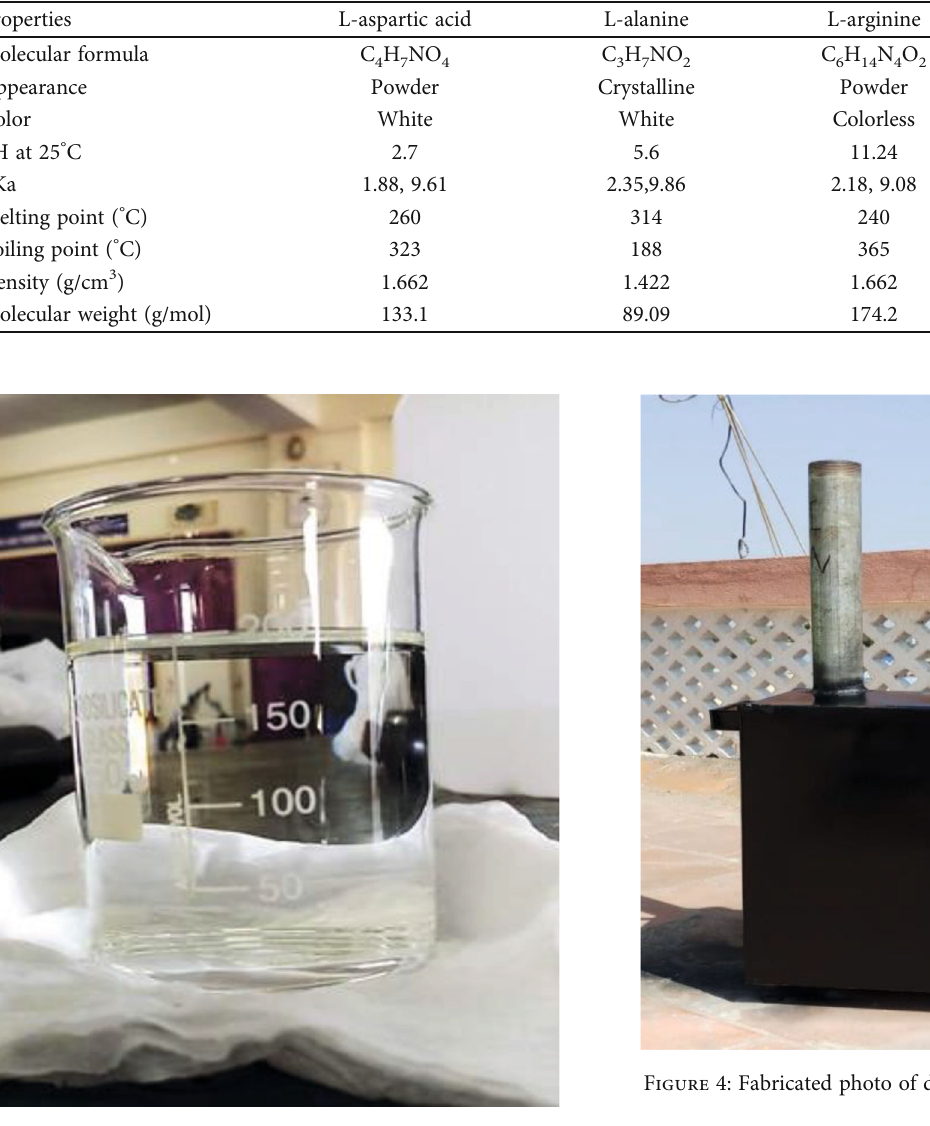
Figure 2: Amine solution used.